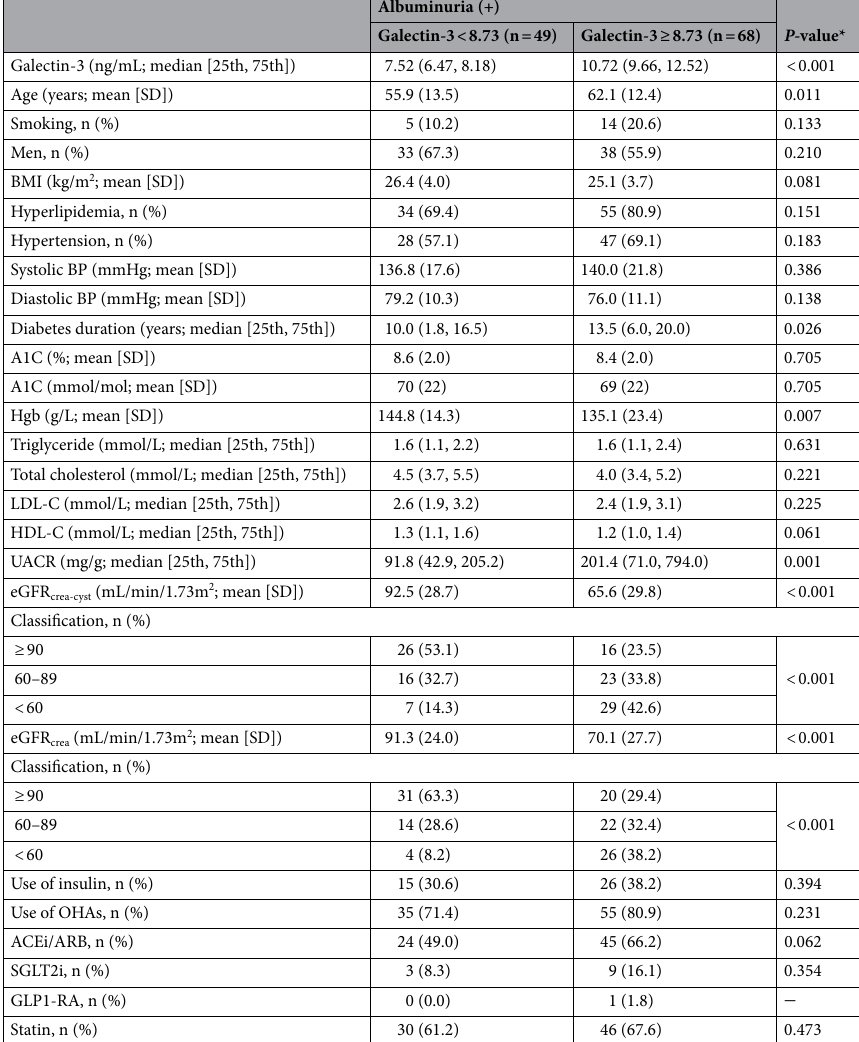
Table 3. Characteristics of patients with T2DM with albuminuria. Median galectin-3 for all patients (8.73 ng/ mL) was unequally divided into normoalbuminuric and albuminuric groups. Data presented as mean (SD)